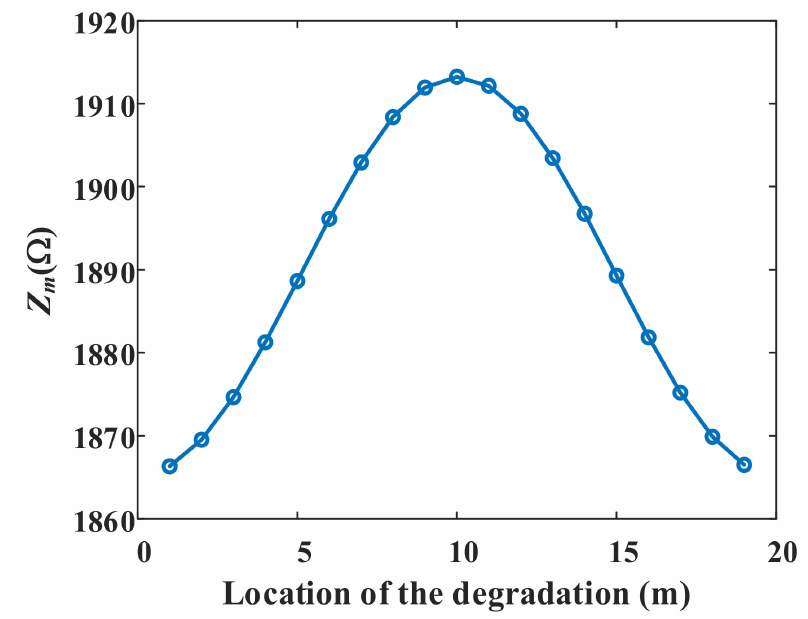
Figure 6. The relationship between the impedance magnitude at the characteristic frequency and the location of the